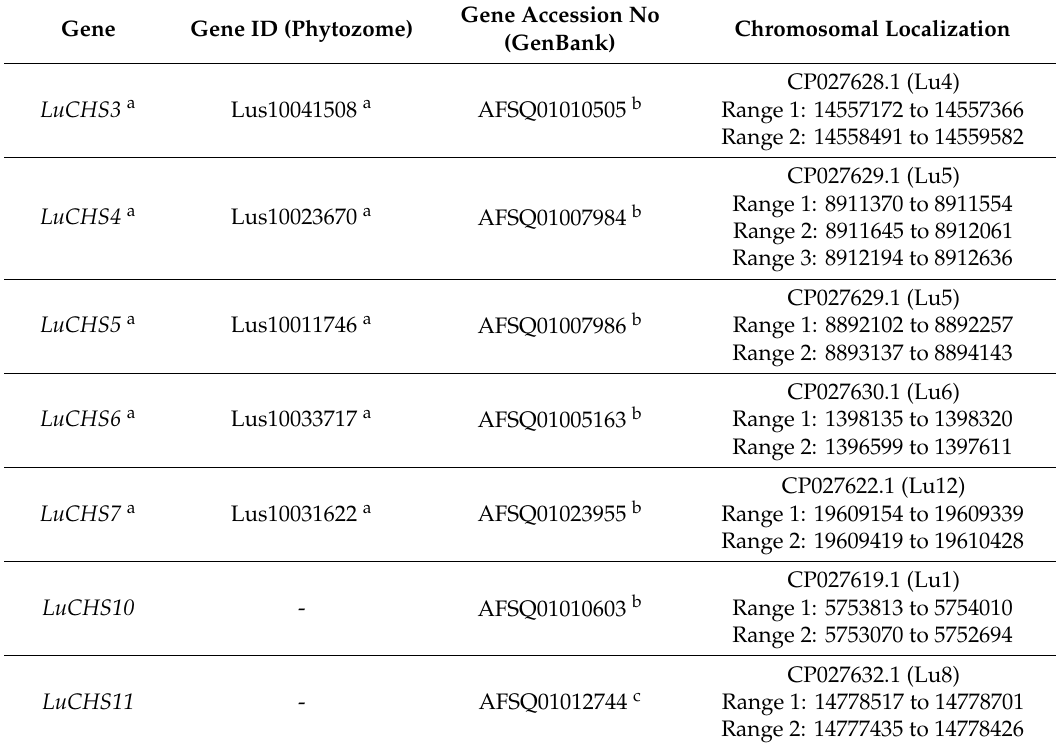
Table 1. Genes encoding CHS in